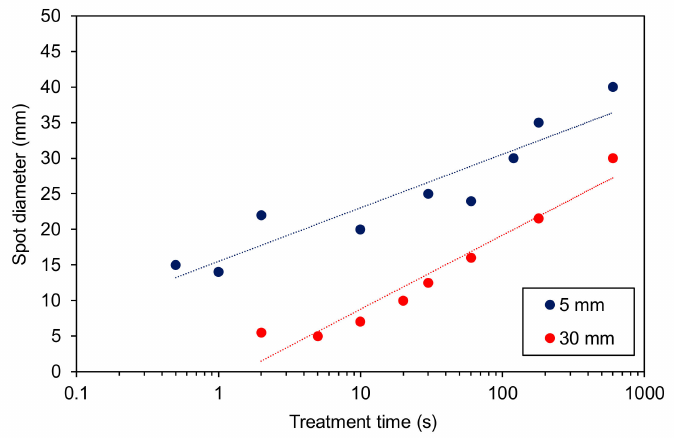
Figure 12. The diameter of the plasma-treated zone on polystyrene samples versus treatment time as estimated from Figures 9 and